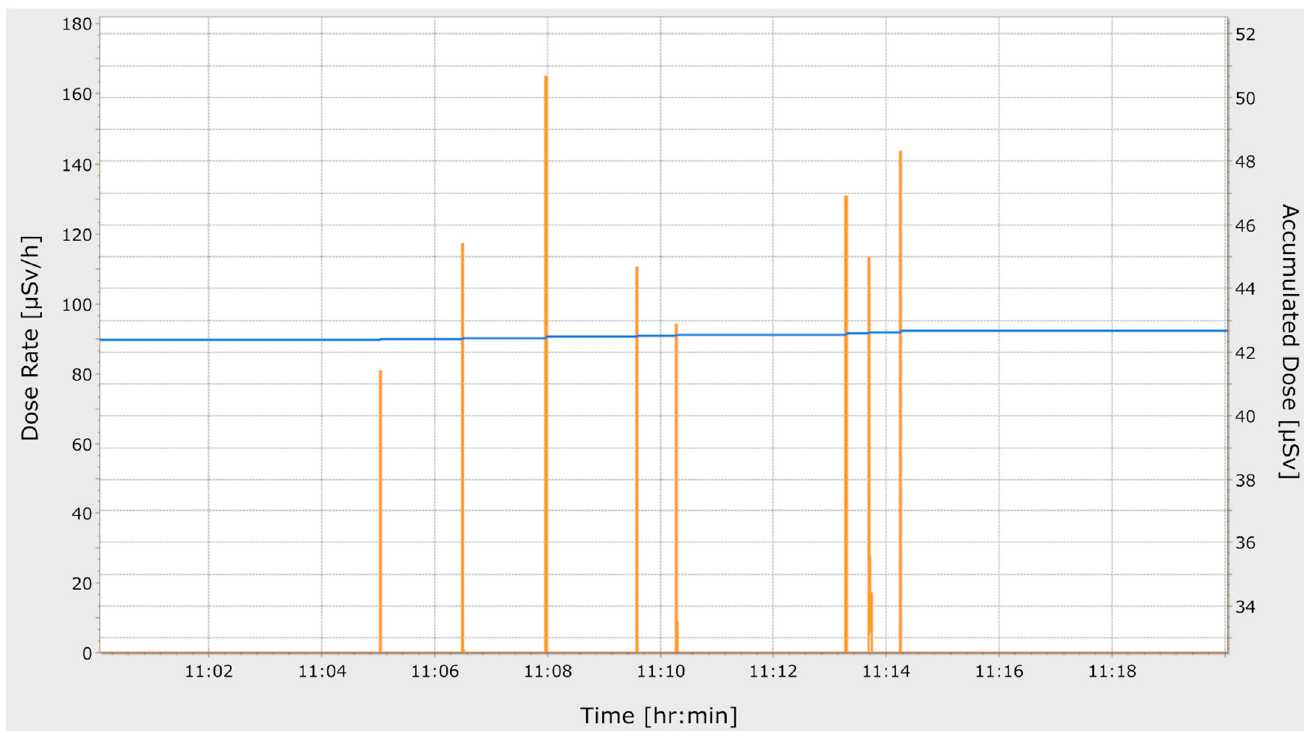
Figure 2. Example readout of the personal dosimeter of an intervention in workflow II (radiologist inside the radiation protection cabin during CT scans). Each red spike represents an interventional scan. The height of the spikes correlates with the radiation dose depending on the position of the radiologist during scanning. The blue line represents the total accumulated dose of the dosimeter in µSv and demonstrates a minimal increase between the first and last scans. Further, for each intervention, start and end times were documented including patient positioning, procedure planning, sterile dressing and draping, application, and reaction time of local anesthetics to the final control scan after the procedure has ended.